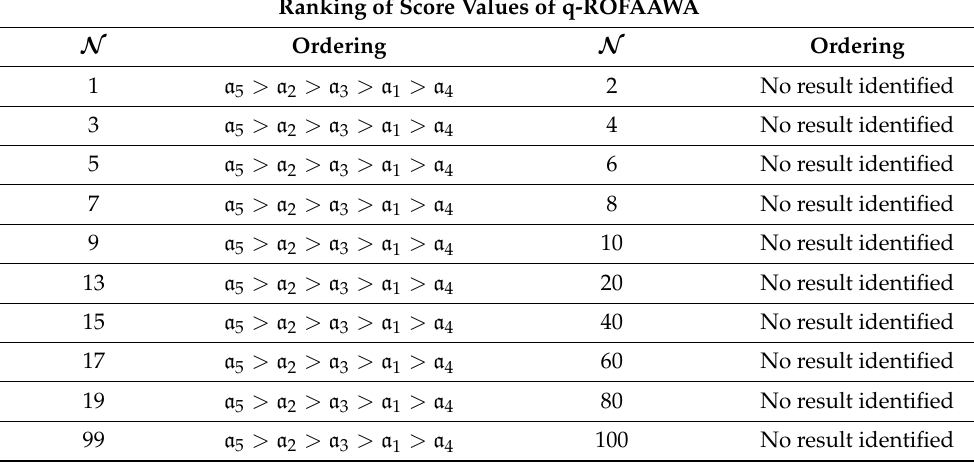
Table 6. Ranking of score values by changing in N q-ROFAAWA. Ranking of Score Values of q-ROFAAWA